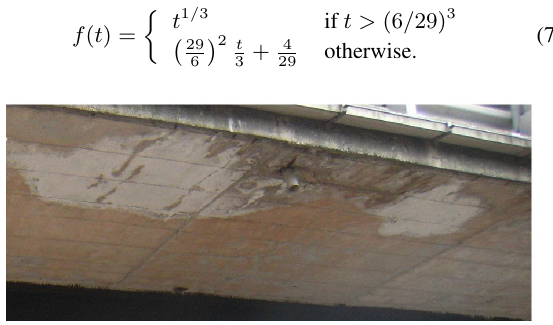
Figure 1: Example of region to be segmented.